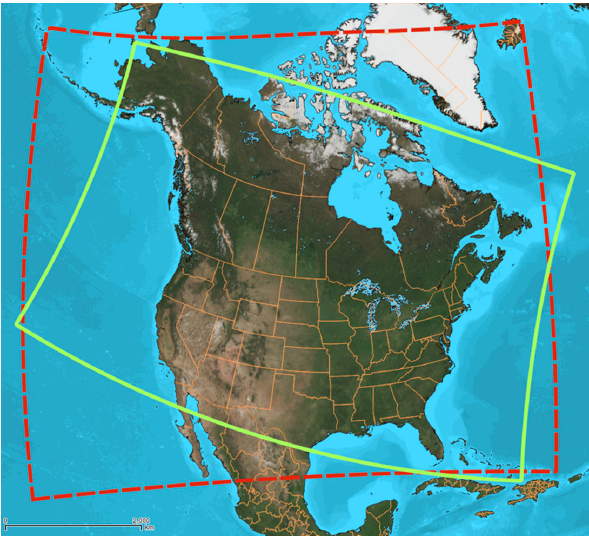
Figure 1. FireWork domain boundaries before (green) and after (red) 7 September 2016. The 10 km × 10 km grid is not shown.